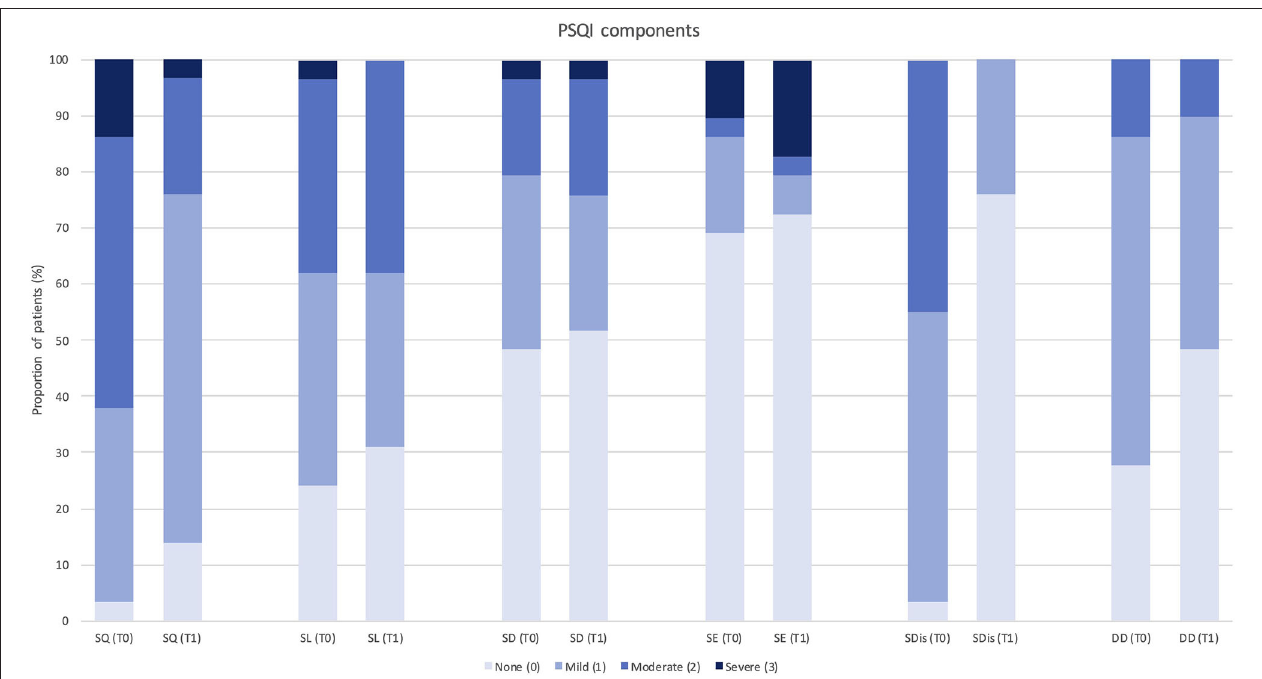
FIGURE 2 | Change in Pittsburgh Sleep Quality Index component score after 3 months of treatment with erenumab ( n = 29). PSQI, Pittsburgh Sleep Quality Index; SQ, subjective sleep quality; SL, sleep latency; SD, sleep duration; SE, habitual sleep efficiency; SDis, sleep disturbances; DD, daytime dysfunction; T0, score at baseline; T1, score after 3 months of treatment.